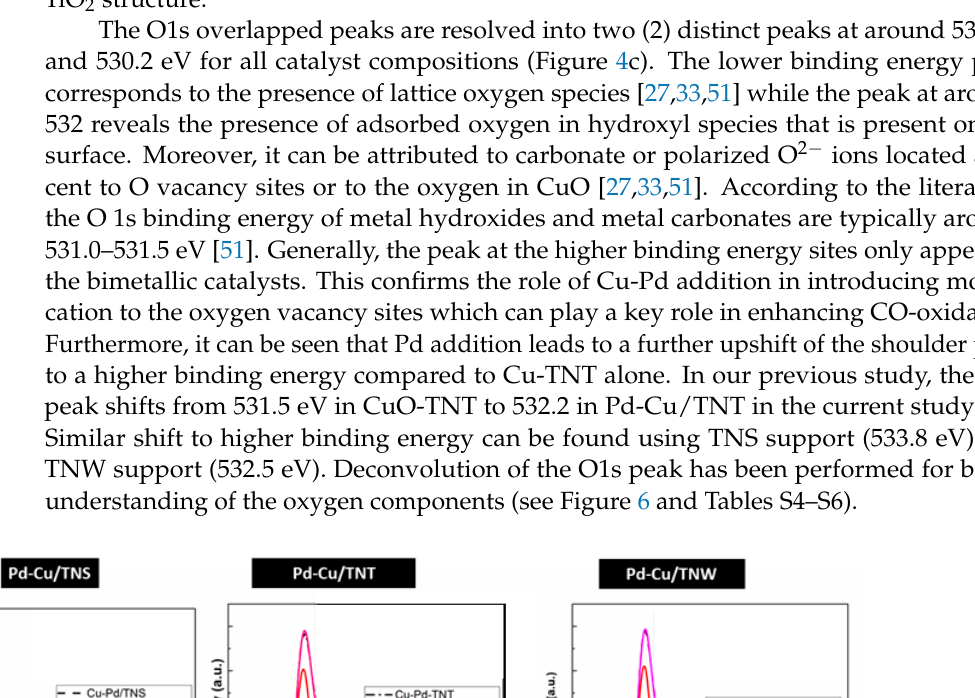
Figure 6. Peak deconvolution for O1s XPS for Pd-Cu/TNS, Pd-Cu/TNT, and Pd